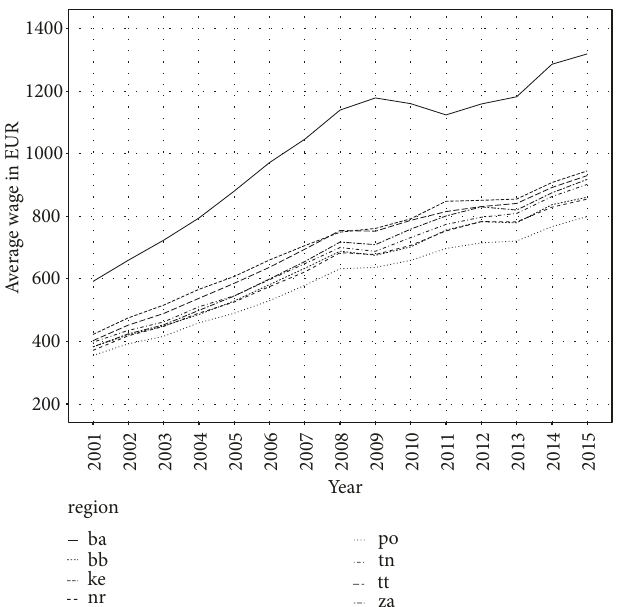
Figure 5: Average wage in Slovak regions.